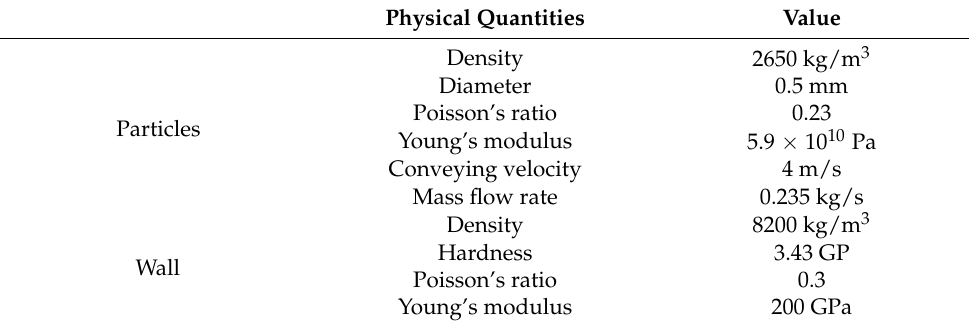
Figure 6. Schematics of the simulated 90° bend ( a ) and the mesh ( b ) employed in the simulation. Table 3. Parameters used in the simulation of erosion model validation.